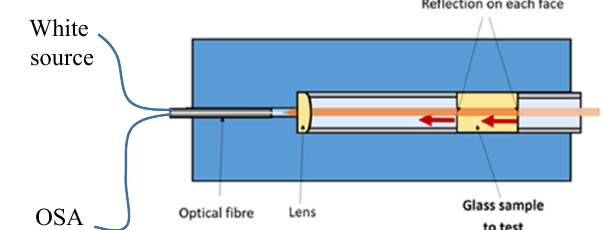
Figure 4: Schematic diagram of the interferometric setup to measure optical path or refractive index change under radiative environment. Table 1 compares the theoretical values of refractive index and the data collected from our experimental setup.